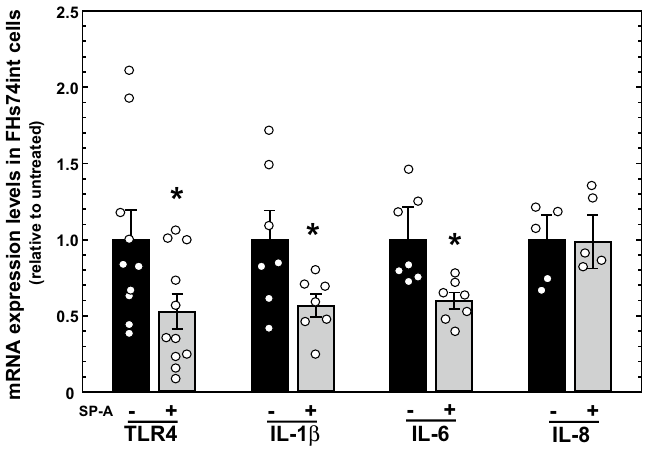
Figure 4. Impact of SP-A exposure on expression of TLR4 and proinflammatory cytokine mRNA in human intestinal epithelial (FHs74int) cells in culture. FHs74int cells were cultured in the absence of presence of SP-A (25 µg/ml) for 24 h. Shown are the results of real-time quantitative RT-PCR analysis of RNA isolated from the cells. All results were normalized to levels determined in untreated cells (set as 1). Shown are the results of 2 determinations, n ≥ 5. * indicates P < 0.05. Figure created using SigmaPlot, ver 14, www.systa tsoft